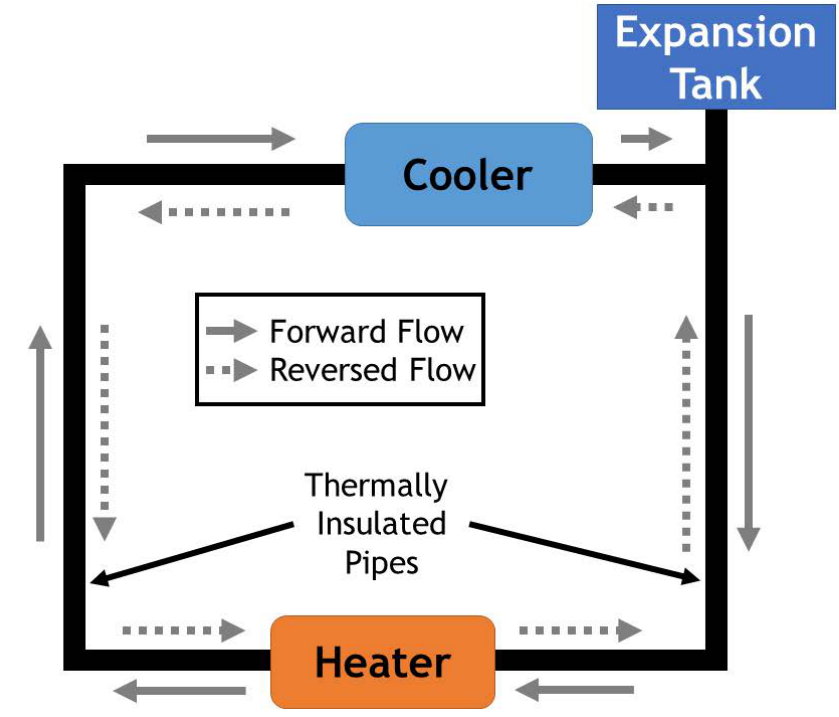
Figure 1. Schematic diagram of the NCL